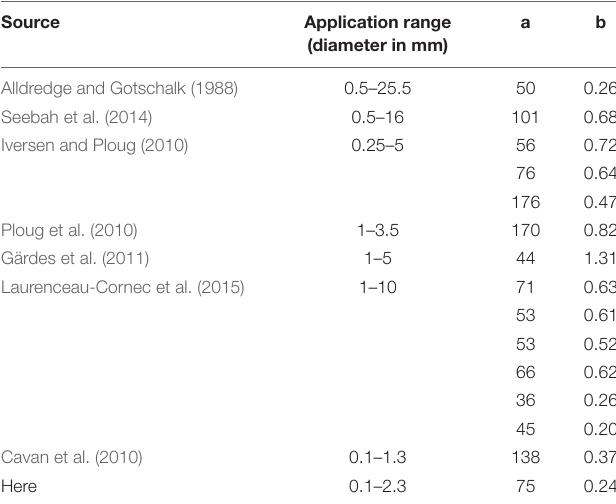
TABLE 3 | Size-to-sinking velocity conversion parameters in the literature.